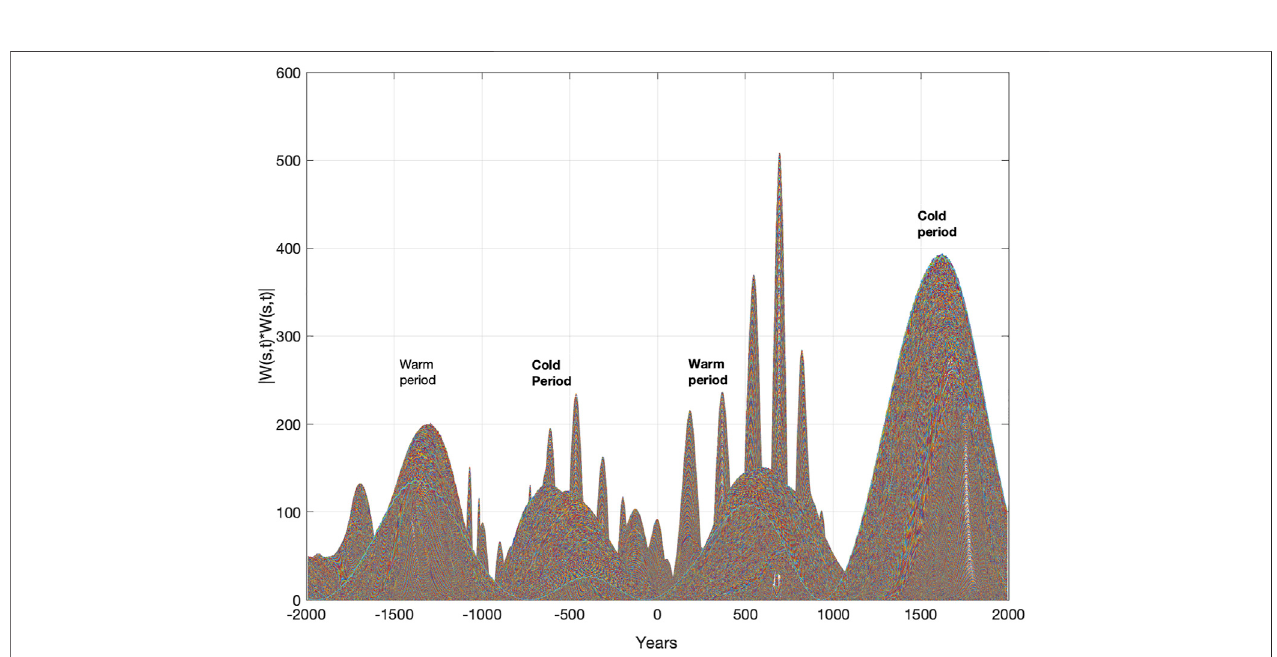
FIGURE 10 | Greenland ’ s GISP2 temperature wavelet power spectrum, WPgrt (s, t), for t = ( − 2000 ... 1993) (yr.) and s = (1...2000). The wavelet power spectrum shows dominant warm time periods and cold time periods from 2000